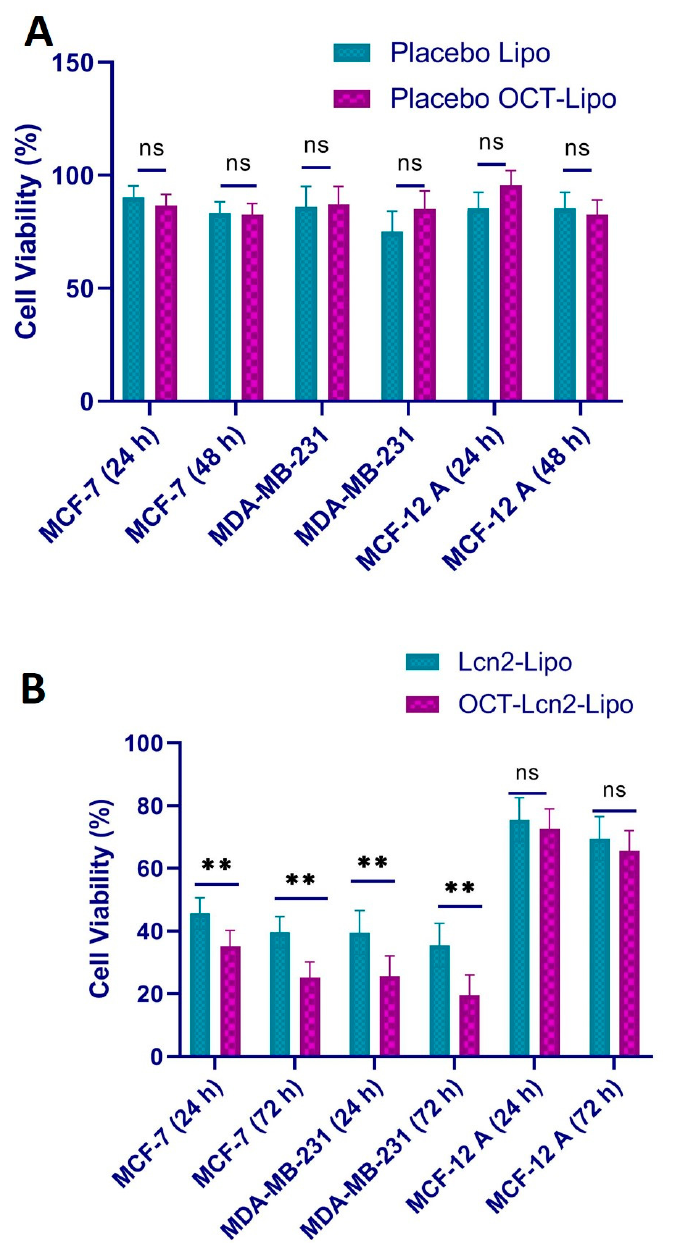
Figure 9. Cell viability for placebo ( A ) OCT-Lipo and ( B ) OCT-Lcn2-Lipo in breast cancer cell lines MCF-7, MDA-MB-231, and normal breast epithelium cells MCF-12A for 24 and 72 h. The data were expressed as mean ± SD (n = 3) (** p ≤ 0.01 and ns = not